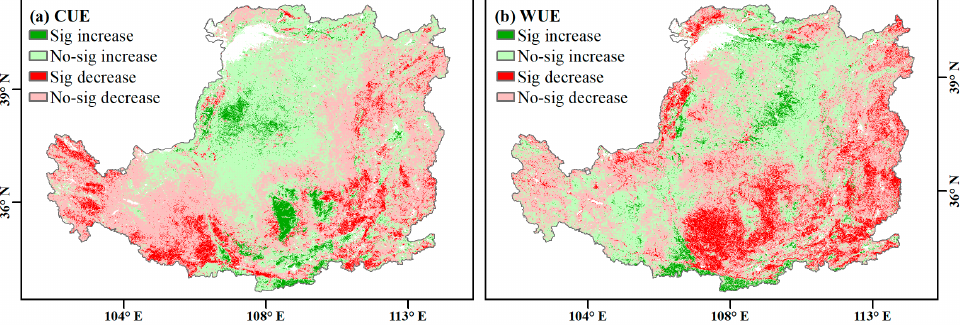
Figure 9. Residual rate of change in carbon and water use efficiency of vegetation on the Loess Plateau ( a ) and its significance ( b ).